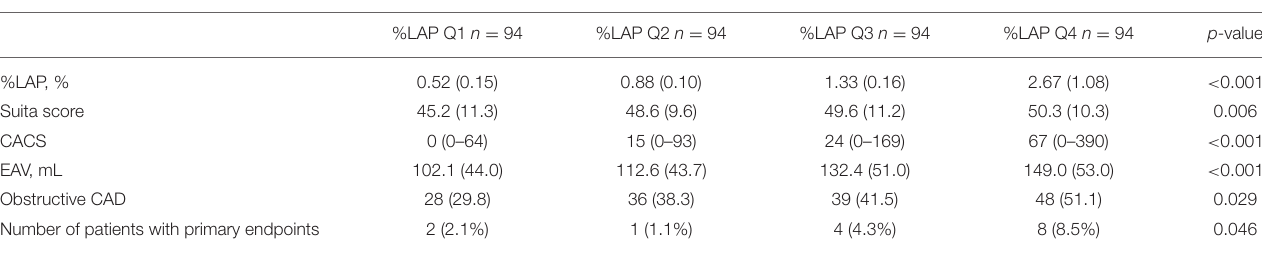
TABLE 3 | Clinical risk score, CCTA findings, and event rates according to quartile of